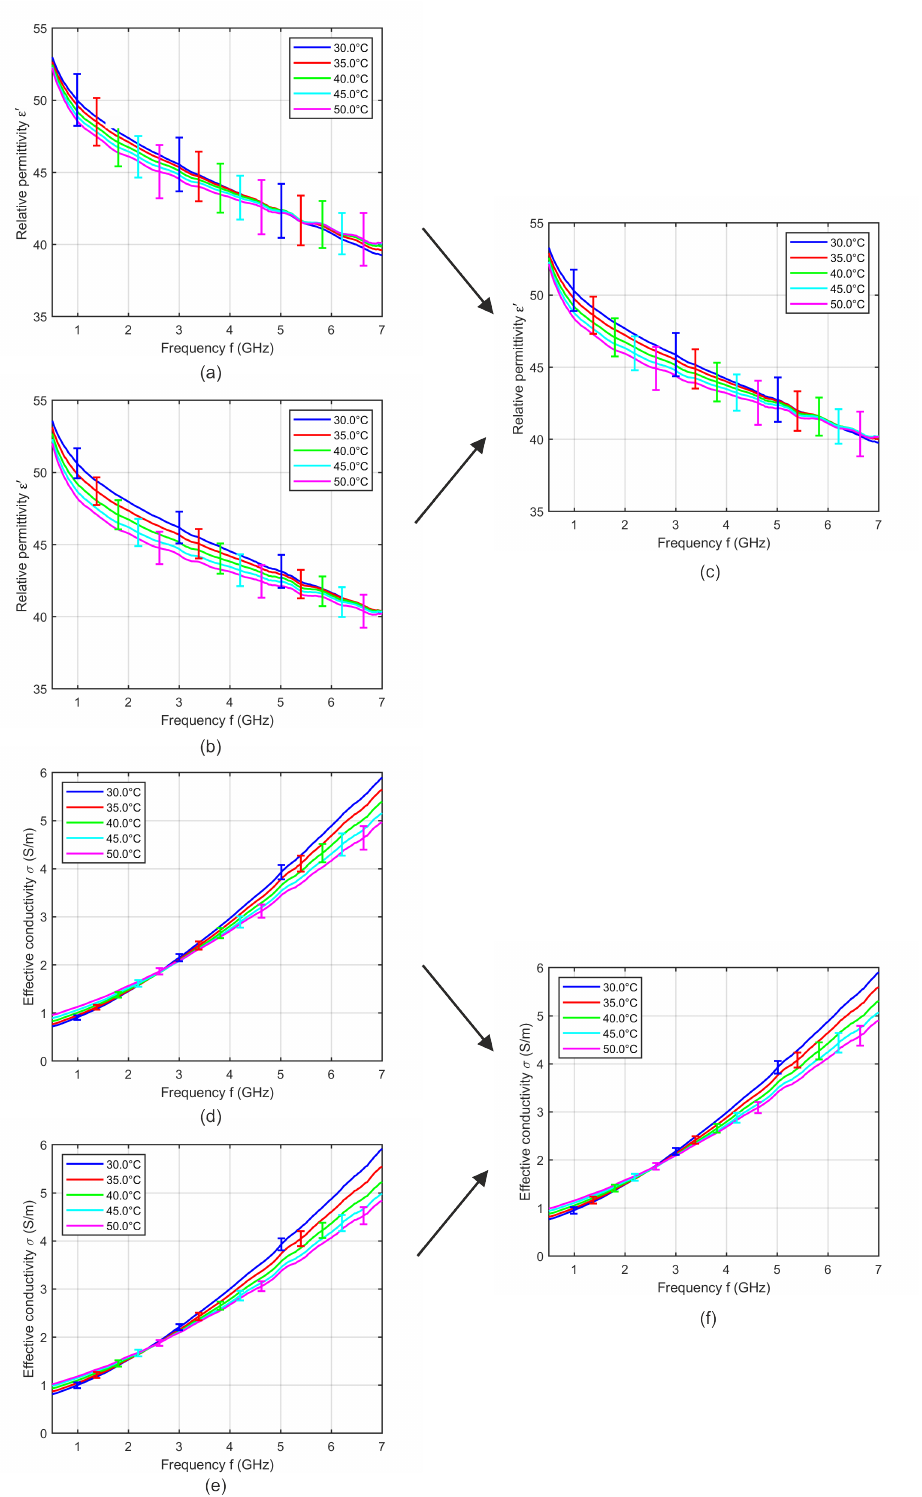
Figure 5. Mean relative permittivity and mean effective conductivity of six porcine liver samples acquired during ( a , d ) heating and ( b , e ) cooling cycle as a function of frequency at different temperatures. ( c , f ) Mean relative permittivity and mean effective conductivity of 12 porcine liver samples including six heating and six cooling measurements. Error bars indicate the corresponding standard